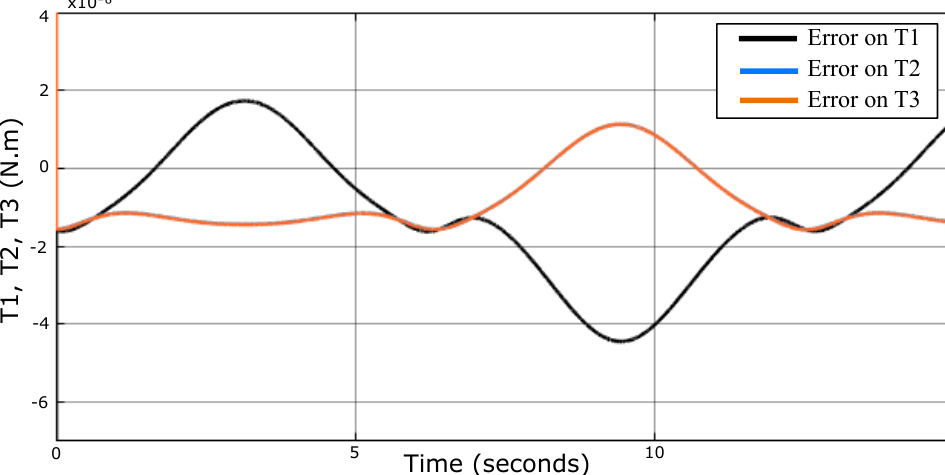
Figure 26. Torques errors signals of the Delta structure (the blue curve match the orange